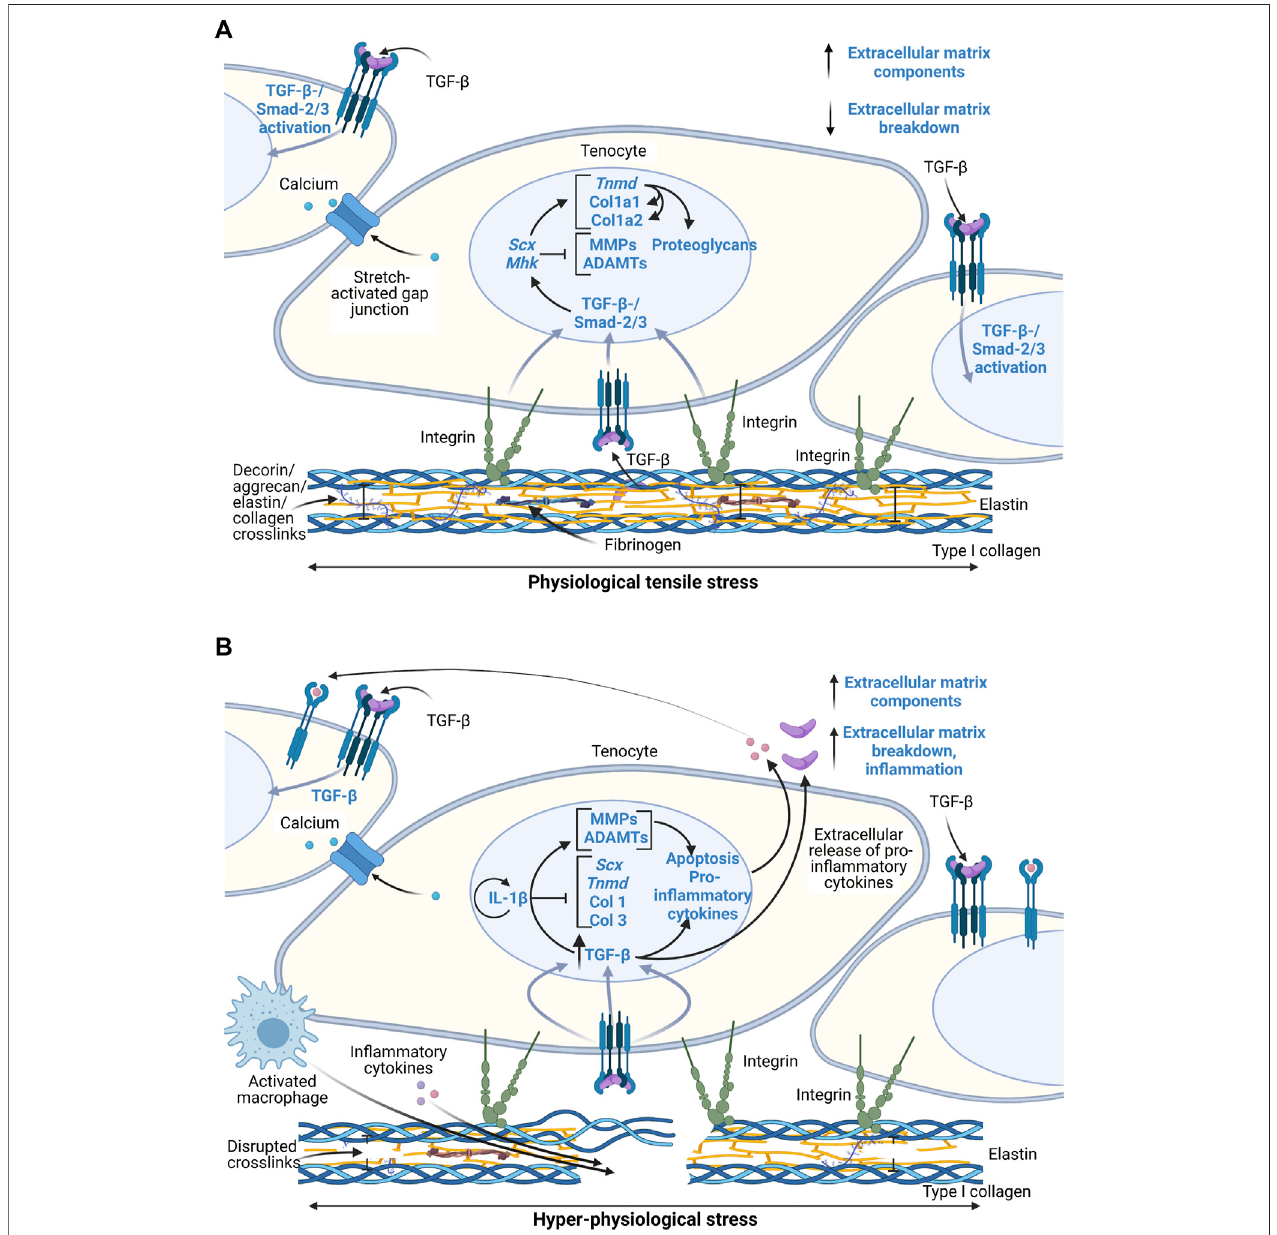
FIGURE 2 | Schematic of proposed tenocyte molecular response to physiological and hyper-physiological mechanical loading thresholds. Created with Biorender.com. (A) Molecular cascade following physiological loading resulting in both integrin-mediated pathways and postulated stretch-activated ion channel pathways to induce a TGF- β -/Smad-2/3 activation and thus transcription of various extracellular matrix related genes and regulatory enzymes. (B) Hyper-physiological loading leads to macro-scale ruptures that induce in fl ammatory cascades through greater activation of TGF- β pathways and IL-1 β that lead to paracrine signaling and ultimately matrix degradation and in fl ammatory cell localization at the injury site. Scx, Scleraxis; Tnmd, Tenomodulin; Col 1, collagen type I; Col 3, collagen type III; MMP, matrix metalloproteinases; ADAMT, disintegrin and metalloproteinase with thrombospondin motifs; IL-1 β , interleukin-1 β ; TGF- β , transforming growth factor β .